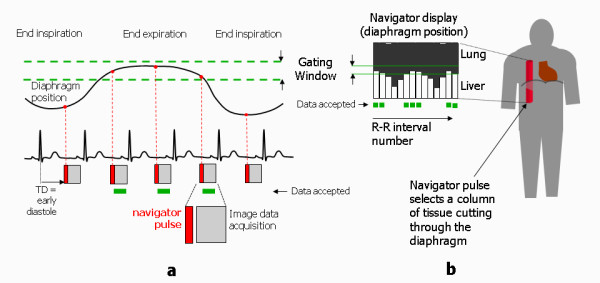
Respiratory gating and navigator echoes. This figure illustrates the principle behind the use of navigator echoes to gate the image data acquisition according to a particular time period within the respiratory cycle. The diagram in (a) shows a cardiac triggered data acquisition with a trigger delay chosen at mid-diastole to minimise the effect of cardiac motion. A curve representing the diaphragm position during respiratory motion is shown above. The effect of respiratory motion is limited by gating the data acquisition, so that image data is only accepted when the diaphragm position lies within a predefined ‘window’ corresponding to end expiration. A navigator pulse (shown in red) is applied immediately before the image data acquisition to excite a column of tissue cutting through the right hemi-diaphragm at right angles (b). The resultant navigator echo is frequency encoded along the length of the column and the navigator echo signal is analysed using a Fourier transform to produce a line of signal. The line signal from each successive R-R interval is added to a navigator display. A computer algorithm detects where the signal intensity changes from a high value (liver) to a low value (lung), representative of the diaphragm position. Where the diaphragm position falls within a predefined gating window the image data acquisition is accepted (indicated by the green dashes). Where the diaphragm position falls outside the gating window the data acquired is rejected and the acquisition is repeated until the diaphragm position again falls within the gating window.